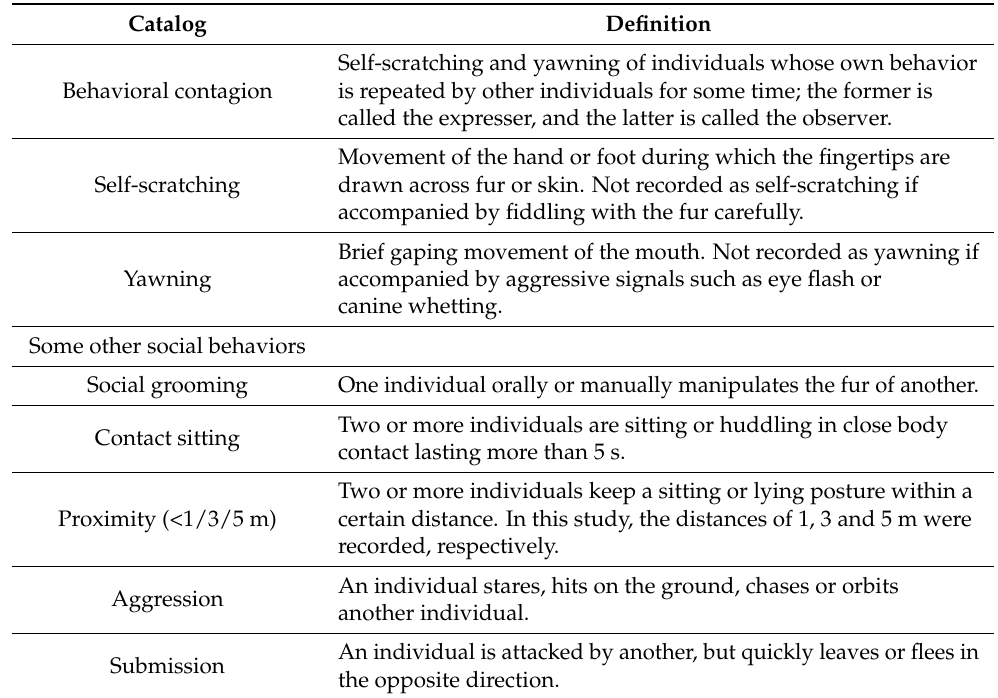
Table 1. Ethogram of behaviors recorded during focal animal